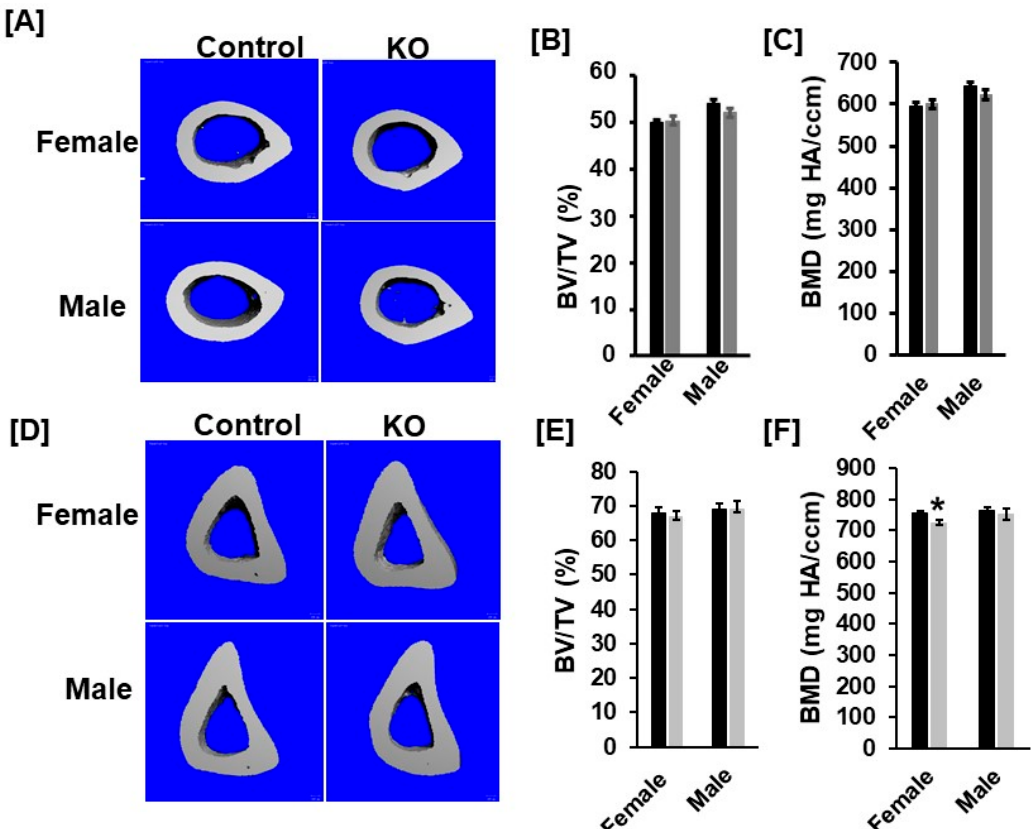
Figure 4. Cortical bone parameters at the femur and tibia mid-diaphysis are not significantly different between Tspan3 KO and control mice. ( A ) Micro-CT images of the cortical mid-diaphysis of the femurs of 13-week-old Tspan3 KO and control littermates. ( B , C ) Quantitative micro-CT data of the femur cortical bone parameters of the Tspan3 KO and their control littermate mice. ( D ) Micro-CT images of the cortical mid-diaphysis of the tibias of 13 weeks old Tspan3 KO and control littermates. ( E , F ) Quantitative micro-CT data of the tibia cortical bone parameters of the Tspan3 KO and their control littermate mice. TV, tissue volume; BV, bone volume; vBMD, volumetric BMD. Values are Mean ± SEM (n = 6–8). *: p < 0.05 as compared to the control littermates.